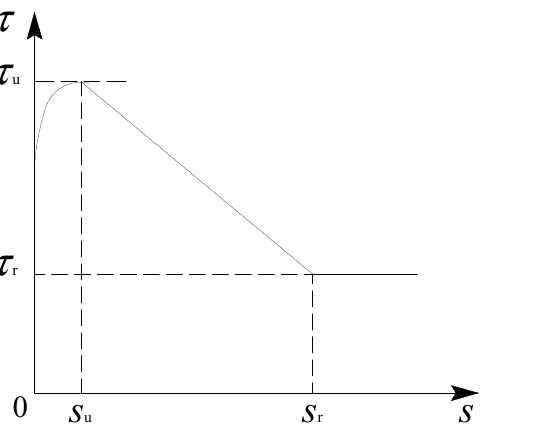
Figure 8. Schematic diagram of the bond − slip constitutive model under monotonic loading. On the basis of the least square method, the pull–out test results of the ribbed steel bars and the ECCs under a monotonic load were fitted to obtain the monotonic bond stress–slip constitutive model between the ribbed steel bars and the ECCs, which can be expressed as